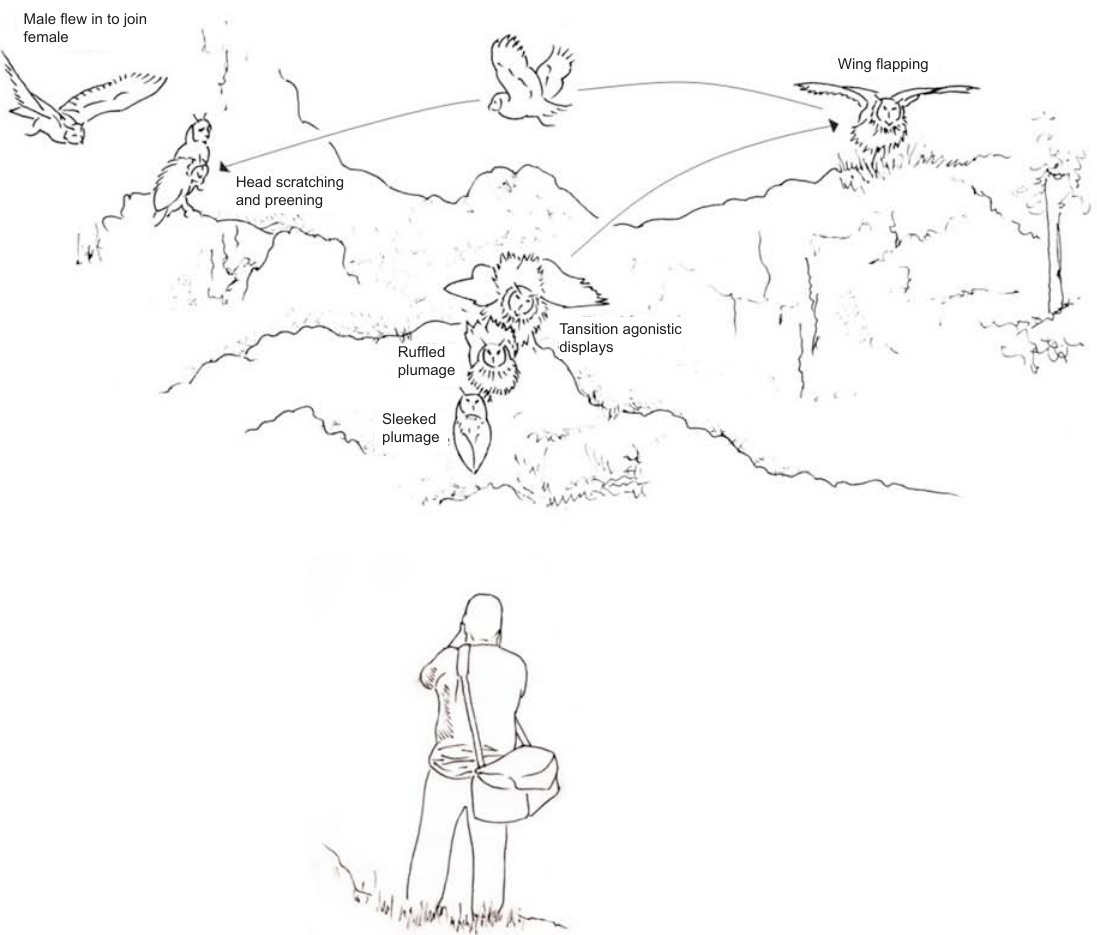
Figure 2. Simplified conceptual representationof brooding female’s behaviour in response to human approach of the nest site (for ethograms refer images 4-11).